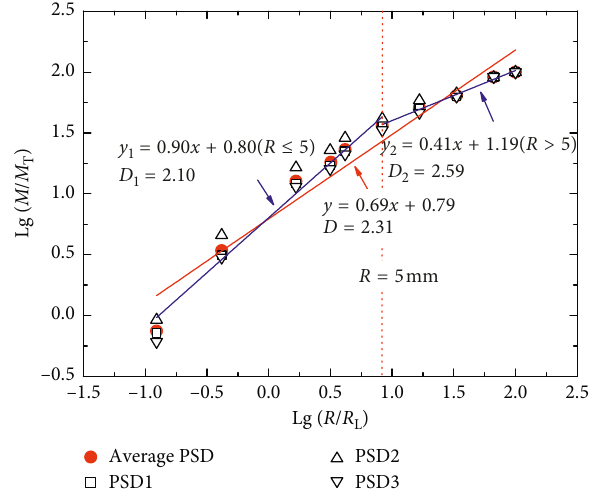
Figure 2: The multifractal properties of SRM.